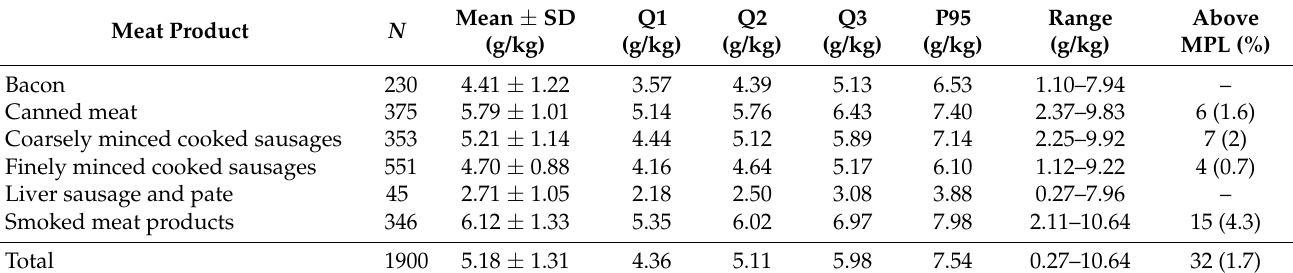
Table 6. Mean levels and ranges for phosphorus (P 2 O 5 ) in processed meat samples (g/kg).